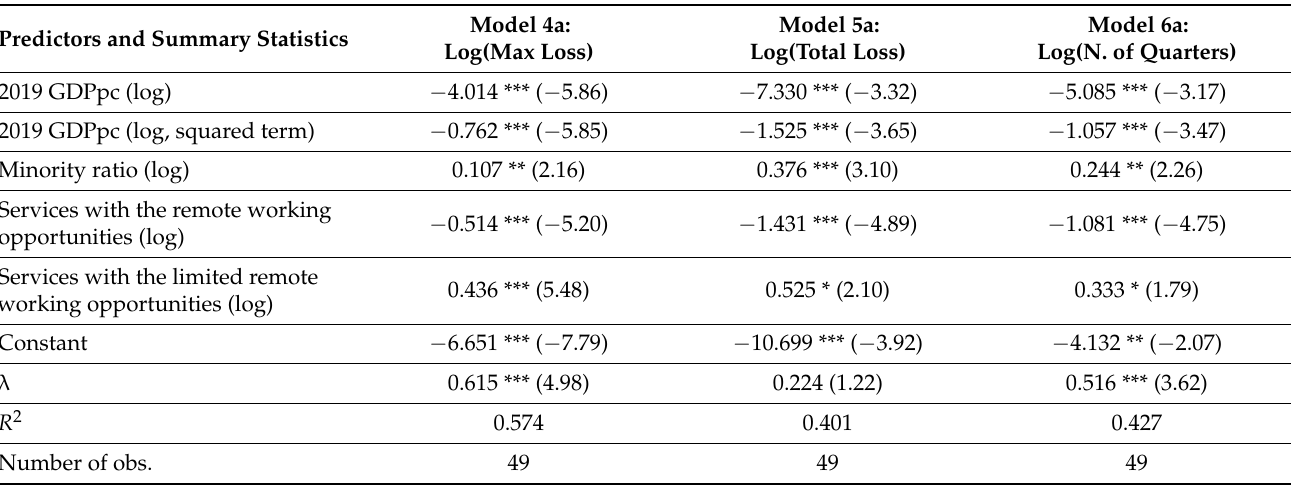
Table 3. Association between the magnitude of the economic losses and socioeconomic characteristics of the states (model type: spatial error